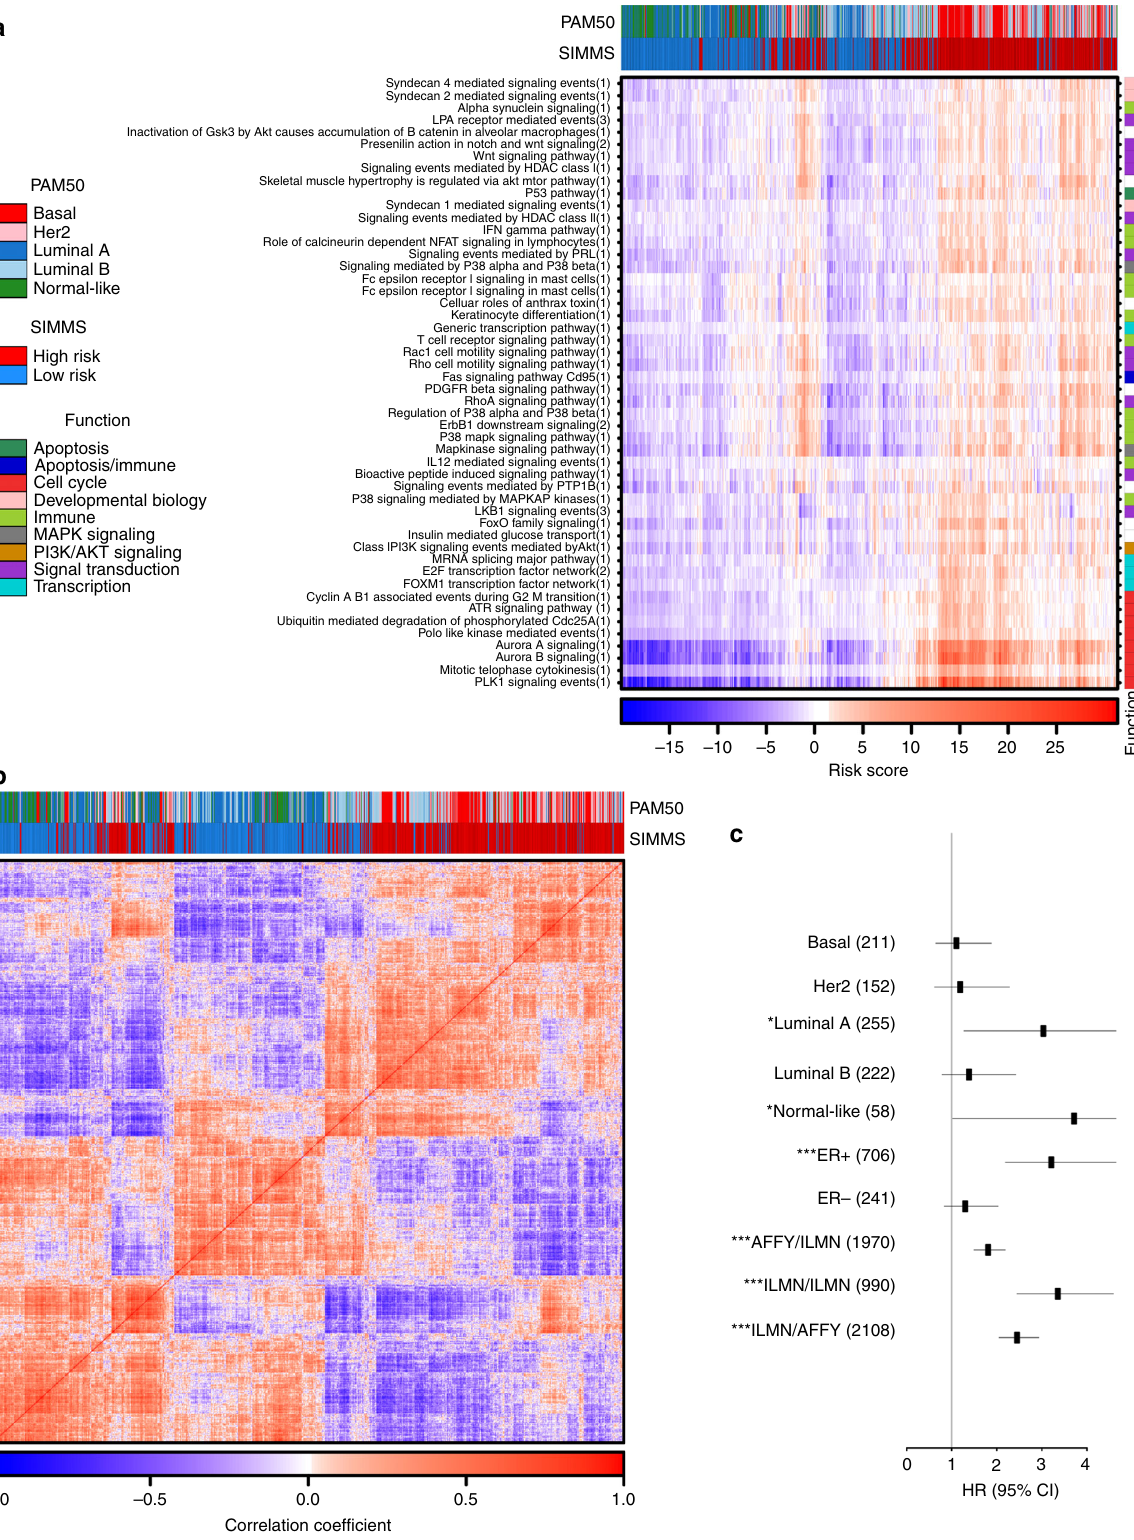
and regulatory pathways (Fig. 4a, b). These clusters were highly concordant with the PAM50 34 intrinsic subtypes of breast cancer ( f -measure = 0.81). Since breast cancer is a heterogeneous disease with distinct molecular and clinical characteristics 34 , we asked whether SIMMS could identify subtype-speci fi c